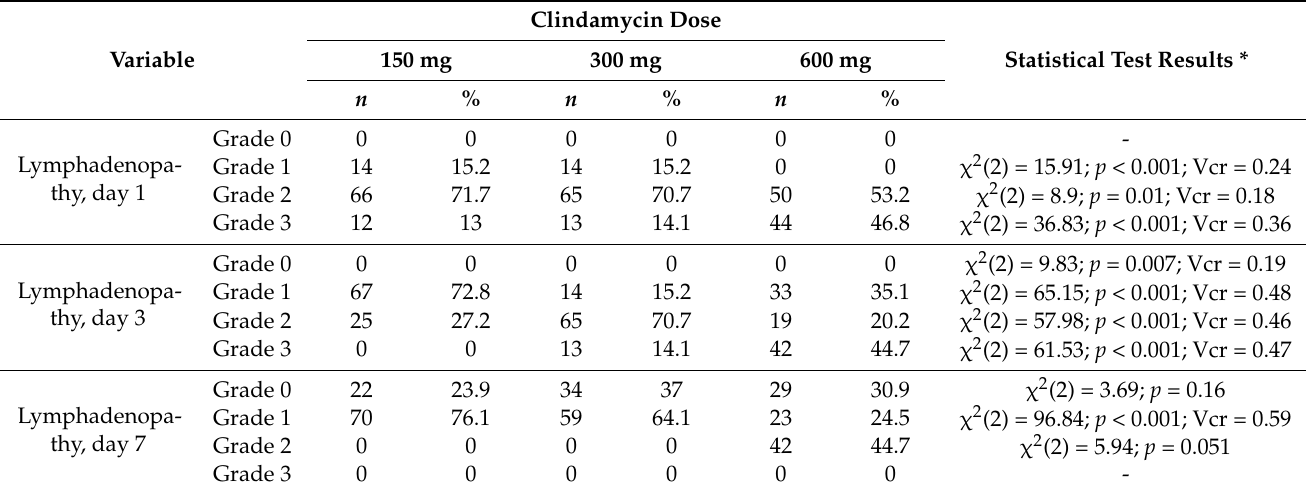
Table 4. Lyphmadenopathy in the study